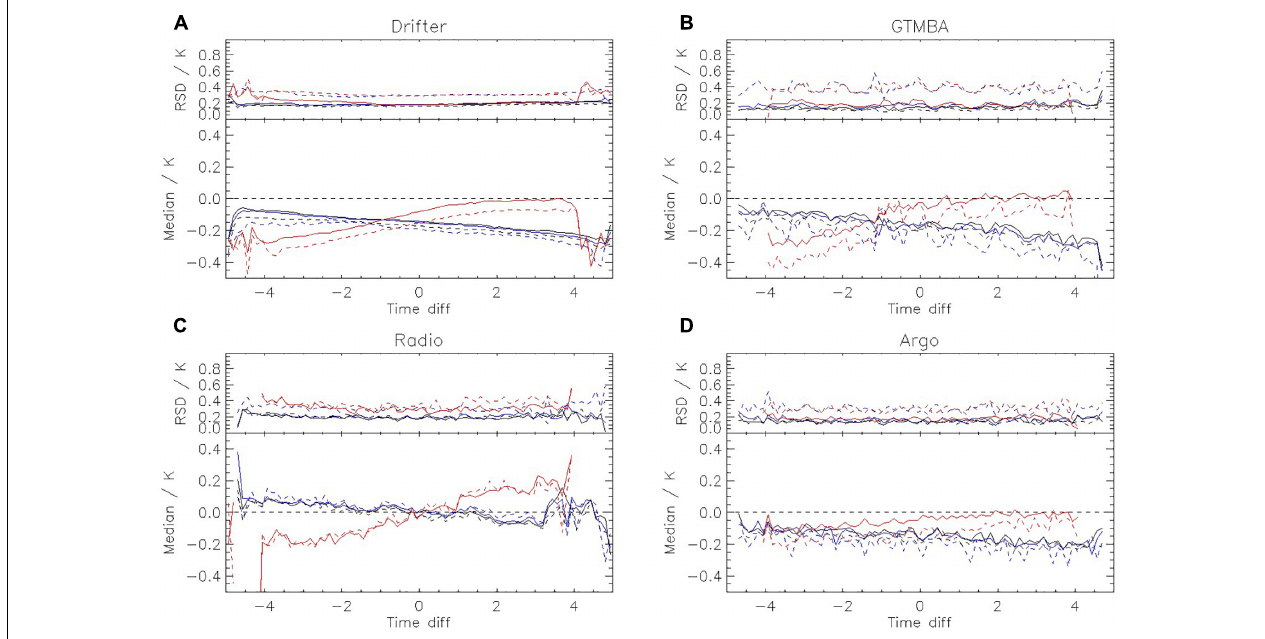
FIGURE 7 | Median (top) and robust standard deviation (bottom) for match-ups between AATSR and (A) drifters, (B) GTMBA, and (C,D) radiometers and Argo floats. Daytime results are shown in red, nighttime in blue and black; solid lines indicate AATSR dual-view retrievals, dashed lines indicate nadir-only. (Reproduced by permission under CC BY 4.0 from